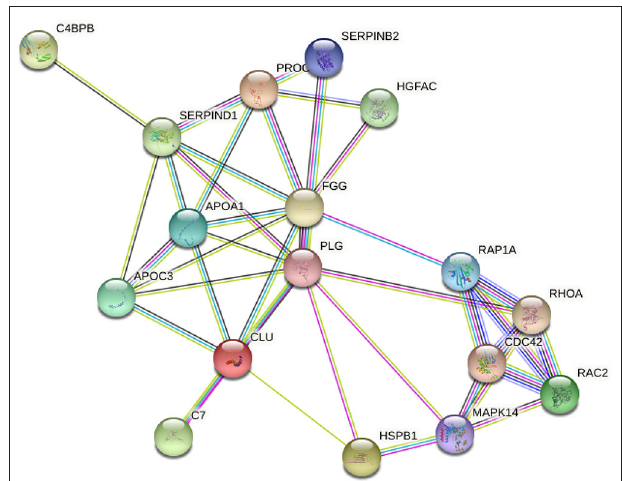
FIGURE 3 | Correlation in protein abundance PPI using String. String (http:// string-db.org/): the direct and indirect interactions between target proteins are found based on the information in the